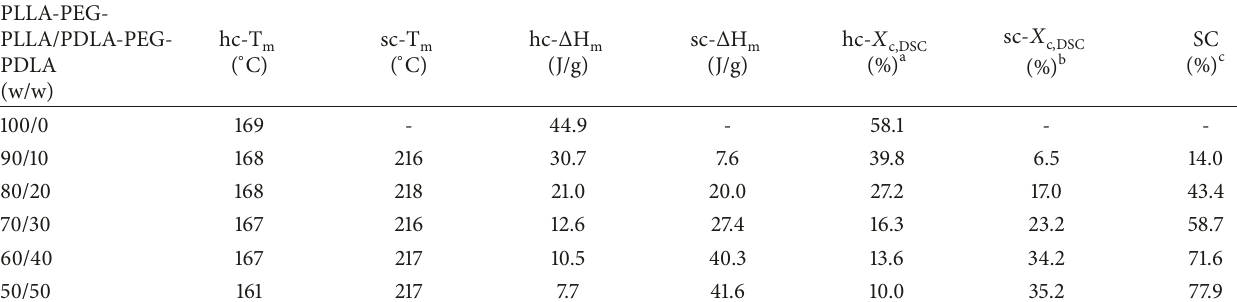
Figure 1: DSC heating thermograms of blends with PLLA-PEG-PLLA/PDLA-PEG-PDLA ratios of (a) 100/0, (b) 90/10, (c) 80/20, (d) 70/30, (e) 60/40, and (f) 50/50 (w/w) (hc-T and sc-T peaks as shown). m m Table 2: DSC results of PLLA-PEG-PLLA/PDLA-PEG-PDLA blends.